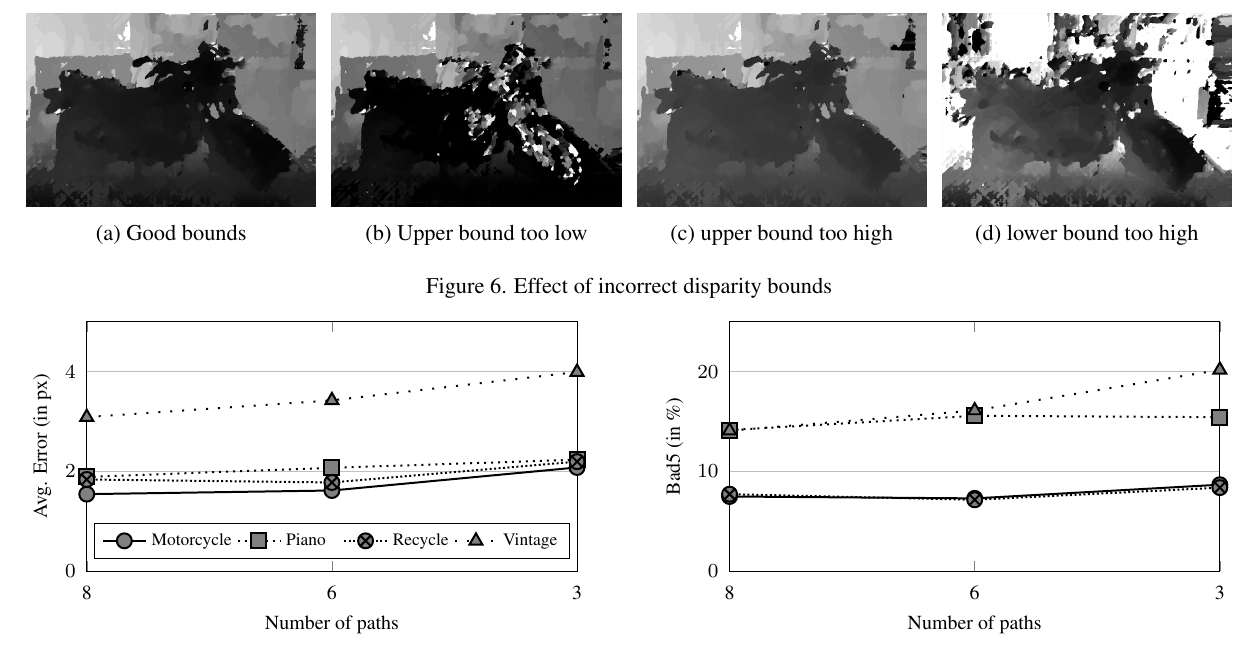
Figure 7. Matching quality as a function of paths for (left) average pixel error and (right) ”Bad5” error on samples from the Middlebury 2014 benchmark dataset